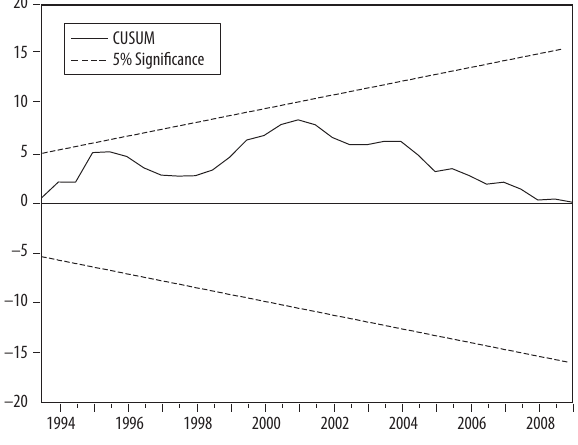
Figure 9. Actual values of office rent index and